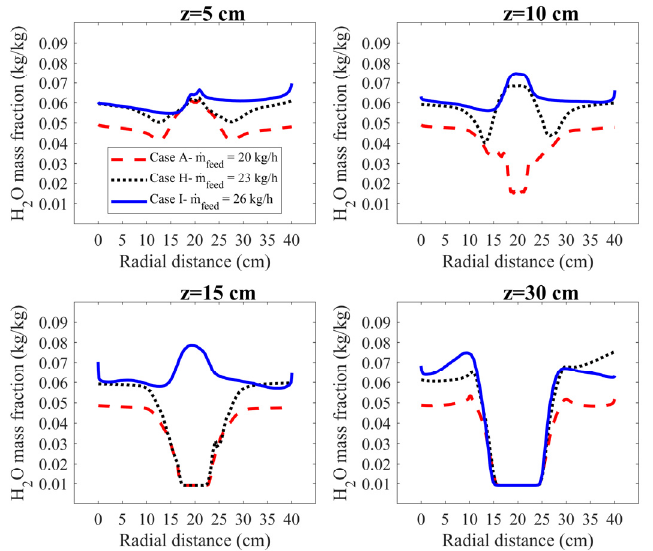
Figure 17. Gas moisture fraction profiles along the radial length of dryer at different distances from the atomizer for centerline of X–Y plane, (where atomizer location is z = 0 cm). Table 7. Particle mean diameter and mean residence time at